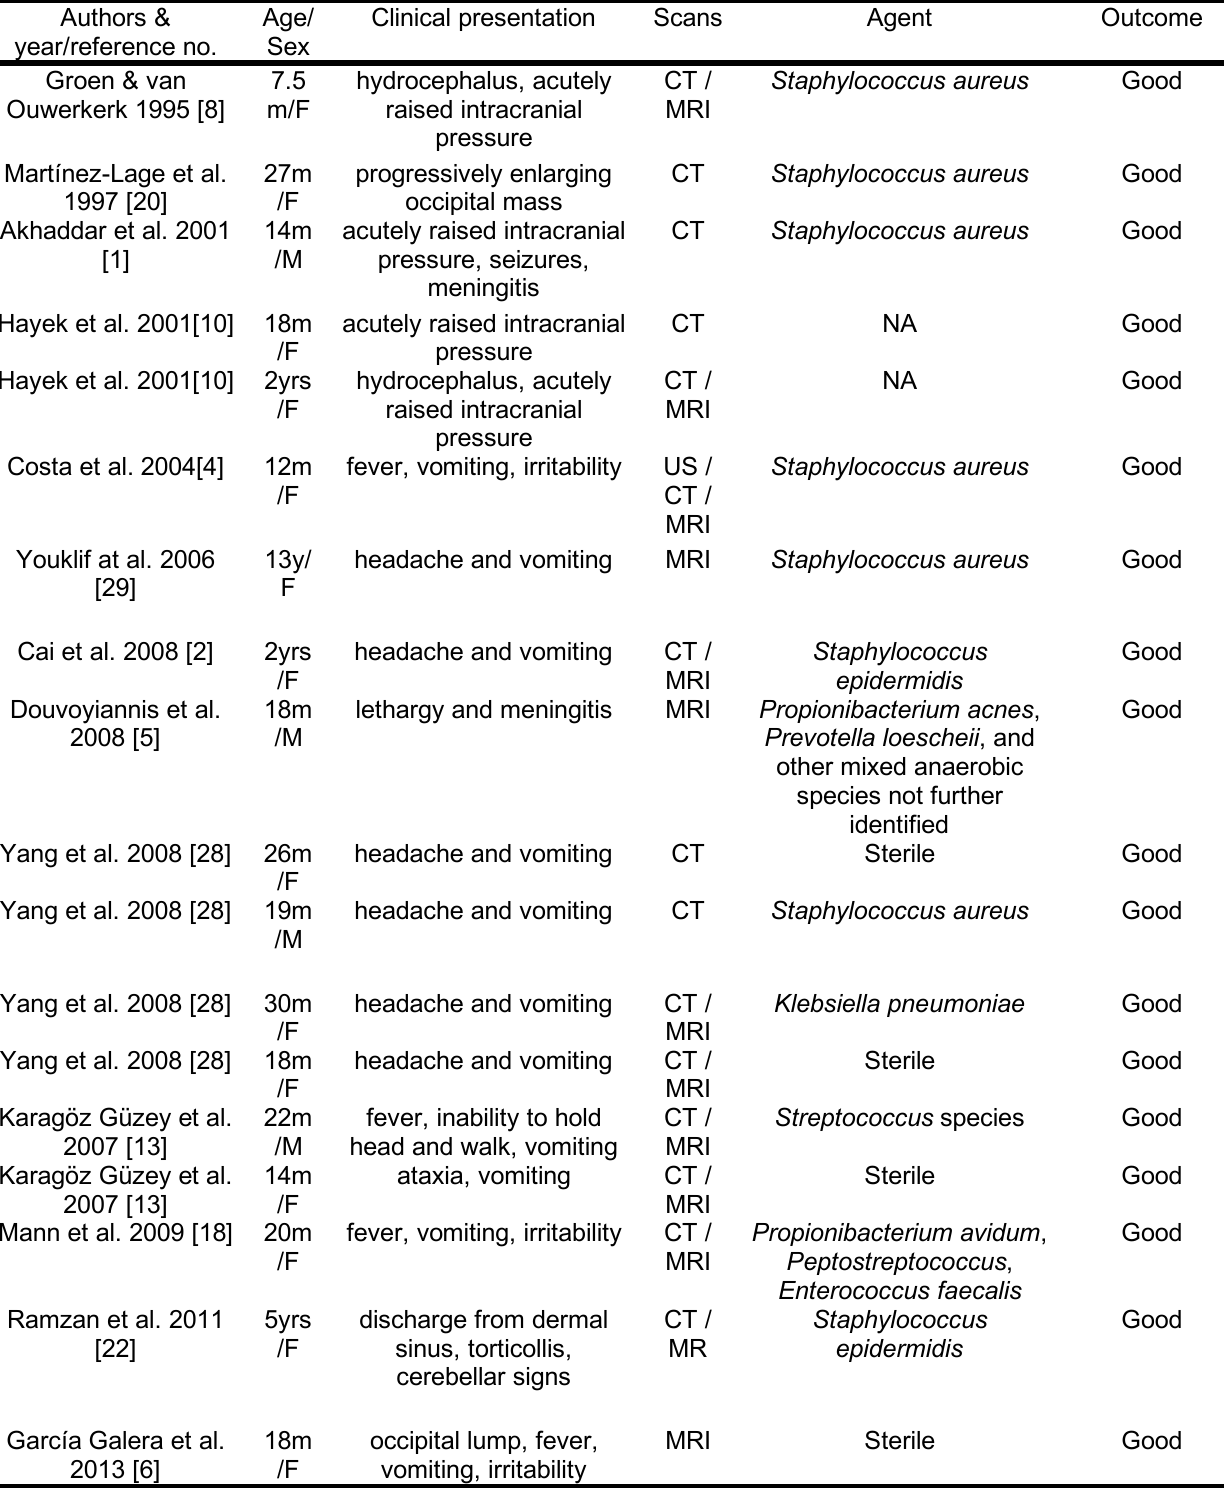
Table 1 - Summary of cases of cerebellar abscesses associated with dermoid tumors of the posterior fossa and occipital dermal